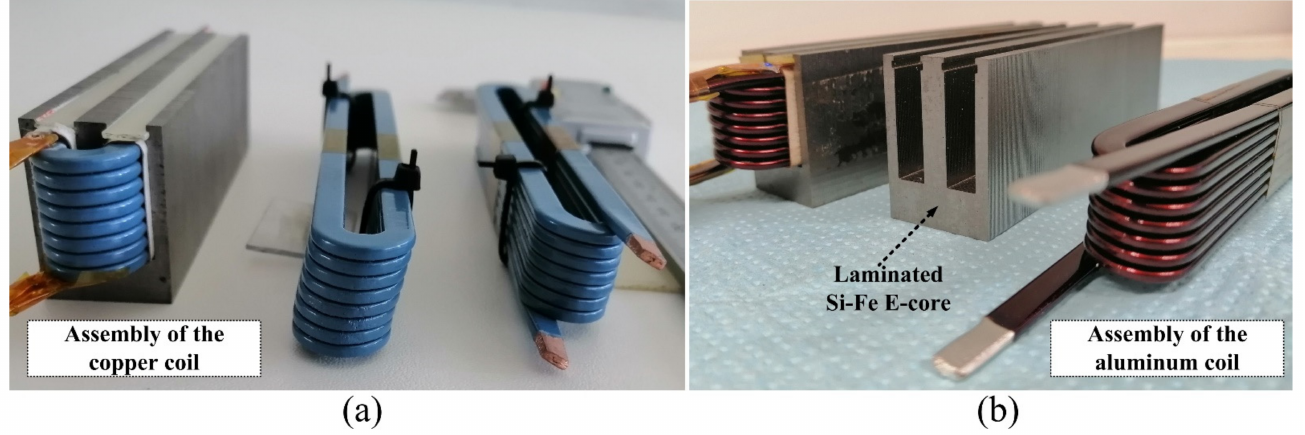
Figure 7. Assembly of the test samples with the 2-slot motorette: ( a ) flat copper coil; ( b ) flat aluminum